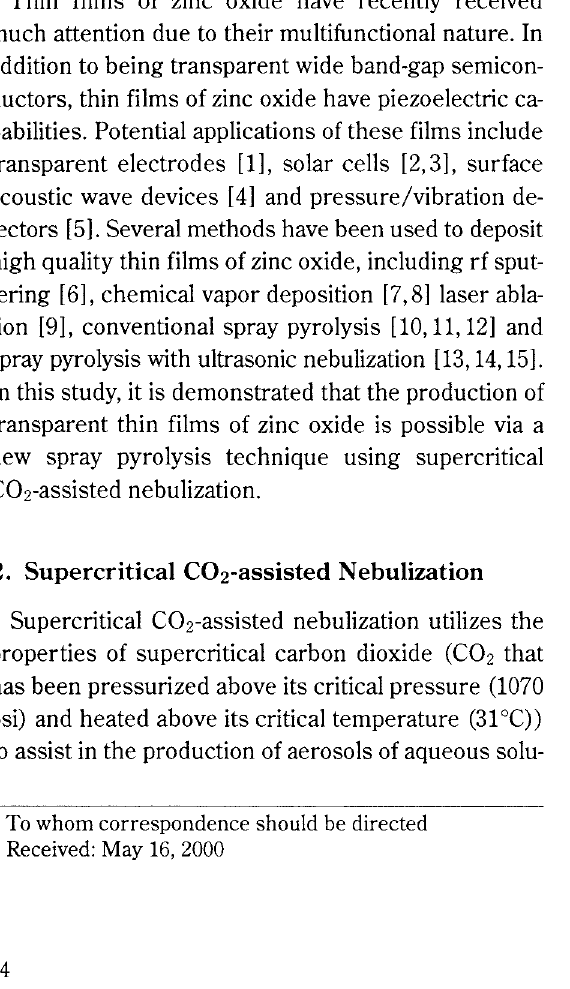
Fig. 1 Schematic for the supercritical C0 2 -assisted nebulization system used for thin film